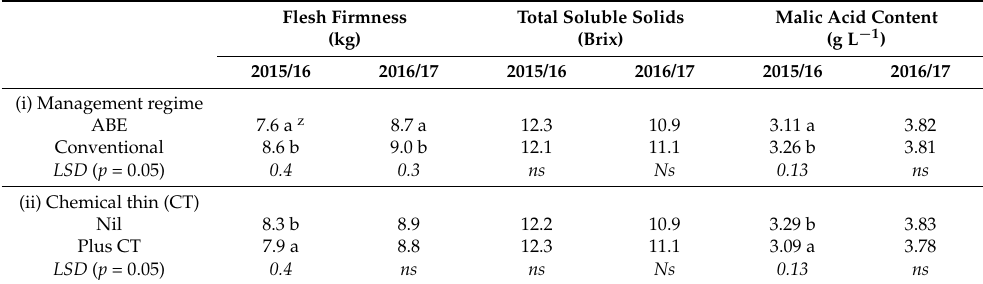
Table 12. Effect of management regime and thinning method on fruit firmness, total soluble solids and malic acid content of ‘Alvina Gala’ (Trial 2). ABE = artificial bud extinction.